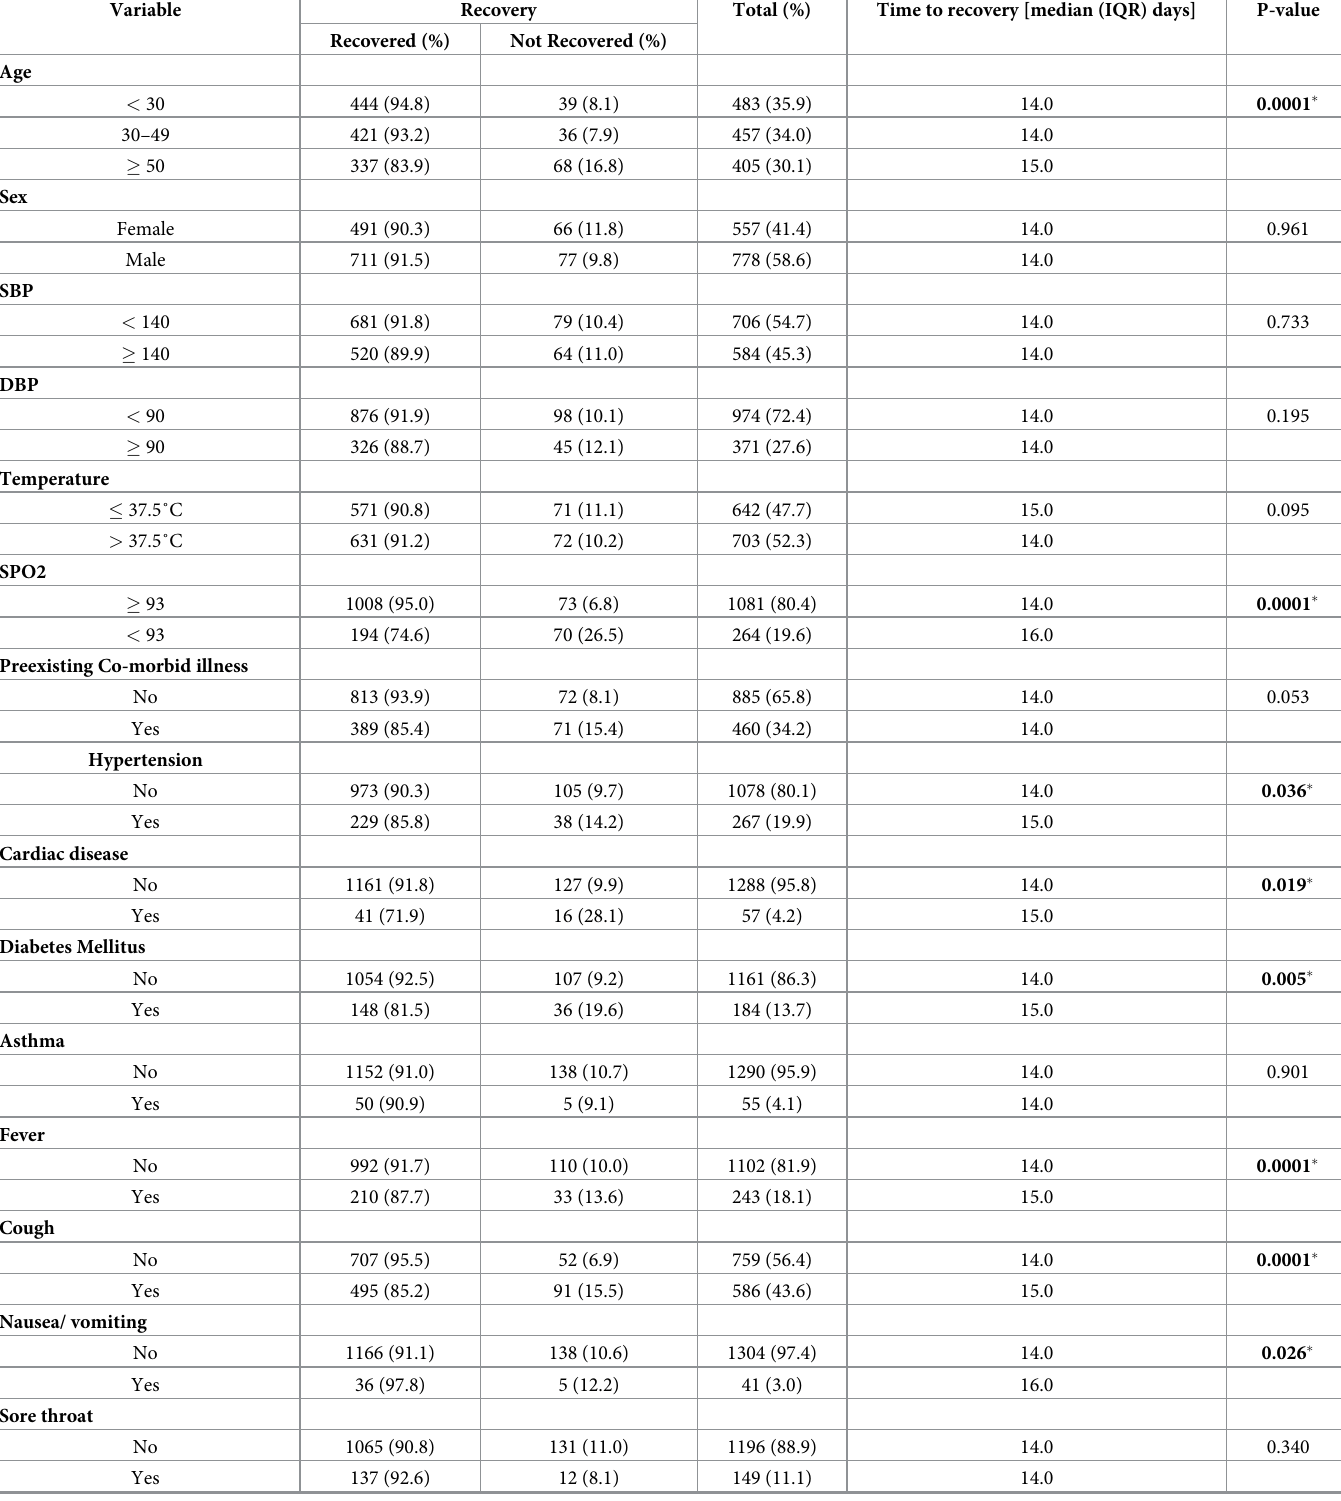
Table 1. Socio-demographic, clinical and laboratory characteristics and censoring status of study participants (n = 1345).